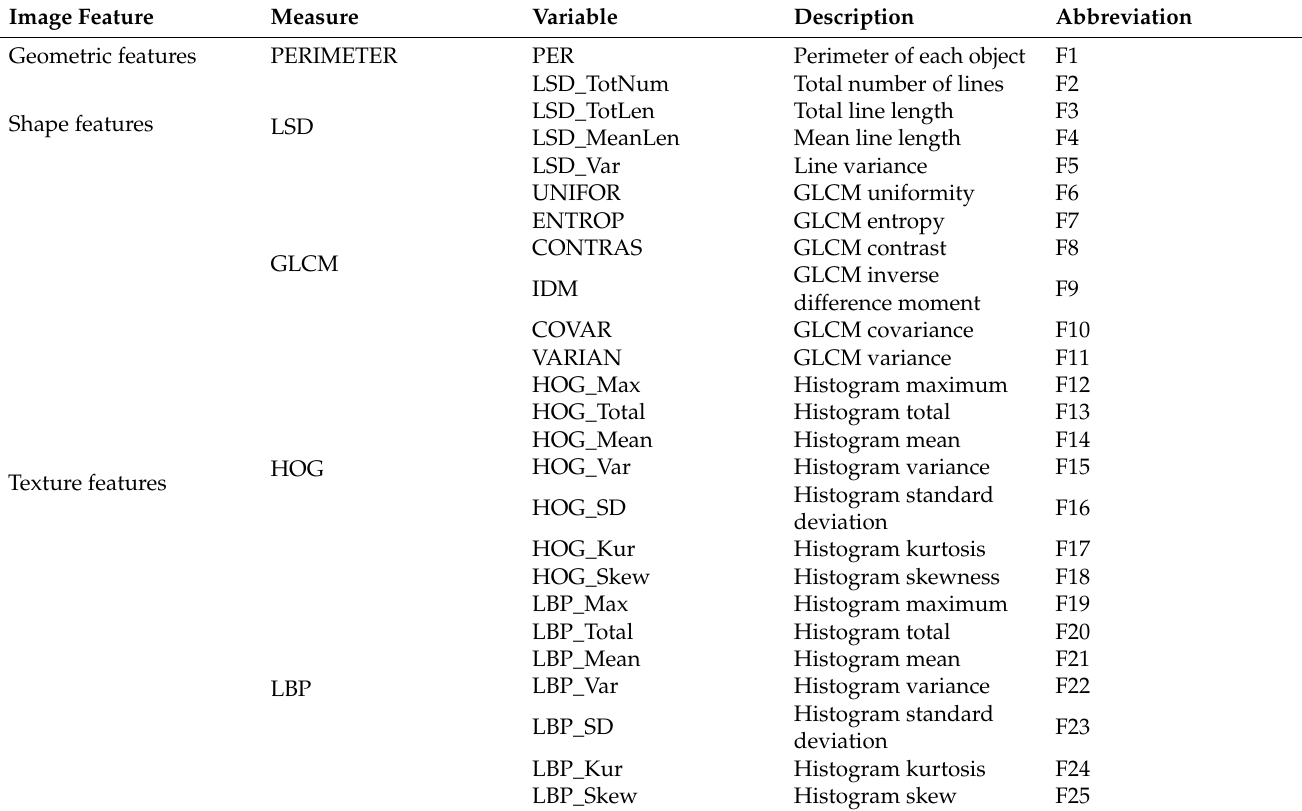
Table 1. Variables derived from remote sensing